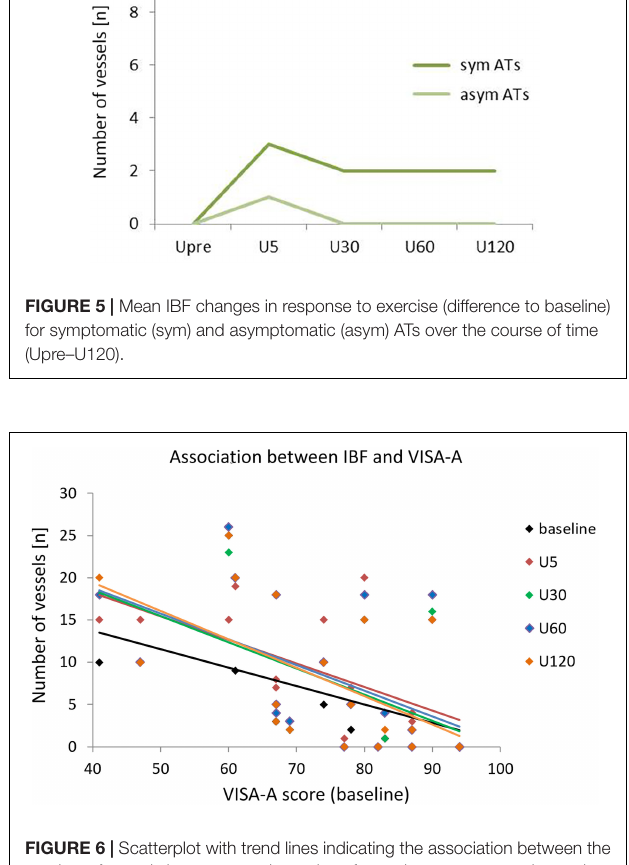
FIGURE 6 | Scatterplot with trend lines indicating the association between the number of vessels in symptomatic tendons for each measurement time point and the VISA-A score assessed at